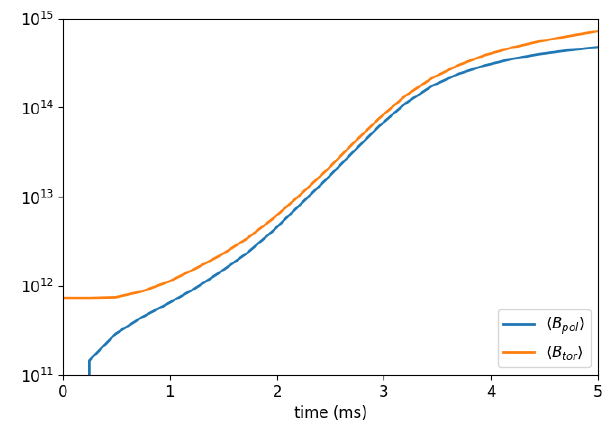
Figure 1. Time evolution in the Run1 for the average value of poloidal ( B pol ) and toroidal ( B tor ) components of the magnetic field in the first 5 ms. Values in Gauss (G) along the vertical